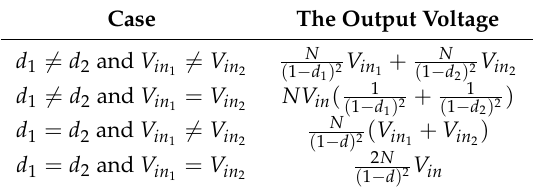
Table 1. Output voltage at different cases when the number of stages are even.